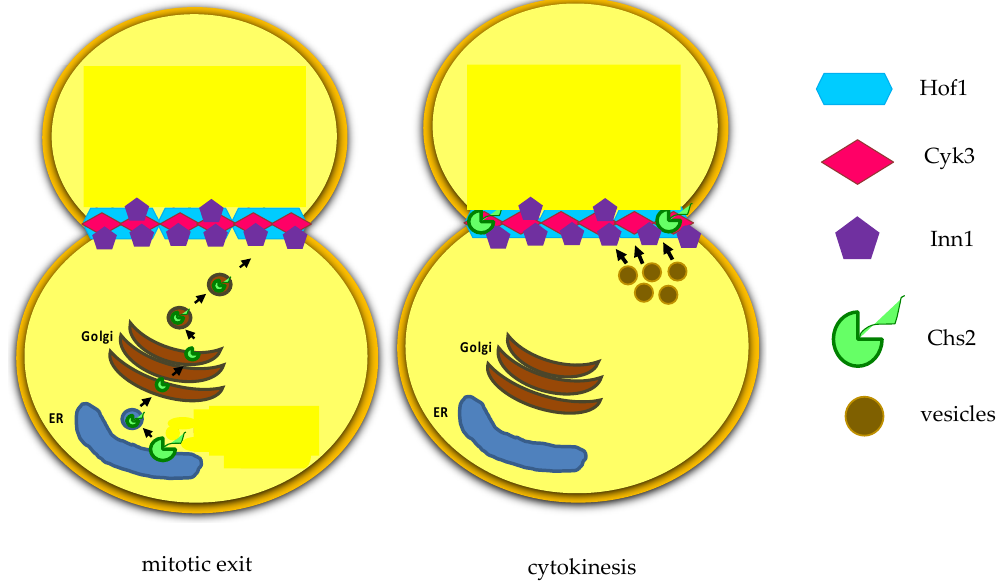
Figure 4. After mitotic exit, the chitin synthase Chs2 is translocated from endoplasmic reticulum (ER).